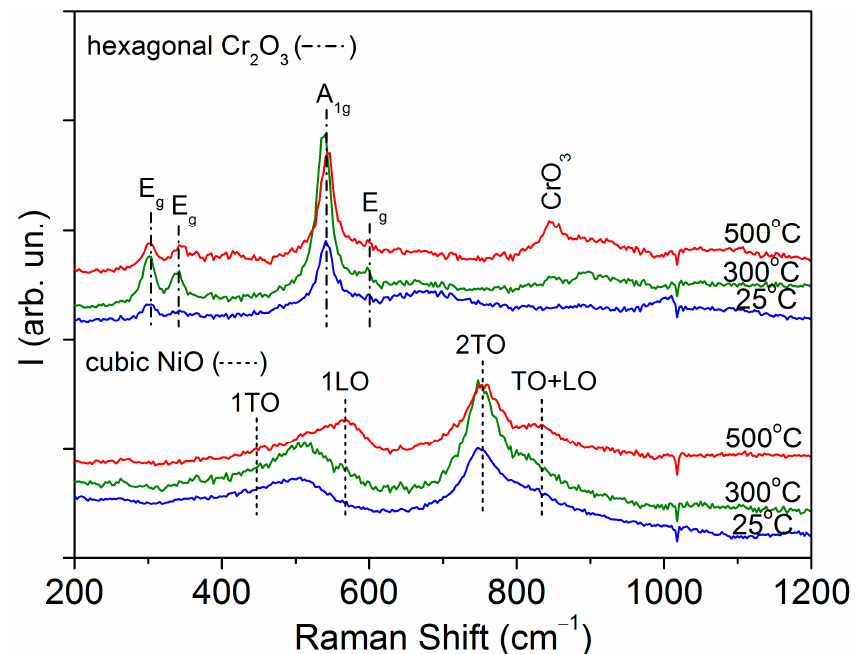
Figure 2. Raman spectra corresponding with the nickel oxide and chromium oxide samples as grown at room temperature and after heating in air at 300 ◦ C or 500 ◦ C. The optical transmission spectra of the various samples are given in Figure 4. This included the standard photopic vision V( λ ), which described the spectral sensitivity of the human eye centered at λ V = 0.55 µ m to better asses the transparency of the films. The visible transmittance (that is, the value T V taken at λ V ) showed the same evolution for the NiO and Cr 2 O 3 layers, increasing from T V = 36 ± 2% for the as-grown films to 54% after heating at 300 ◦ C and higher, to 72%, when the temperature increased to 500 ◦ C. An increment in the visible transmittance with an increasing annealing temperature has been reported for analogous coatings [45–47] with a maximum value around 70% at a 0.55 µ m wavelength [46,47]. In general, the optical transmission is expected to depend on various film properties such as impurity centers, surface roughness and level of crystallinity. For these smooth layers, structural defects and interstitial O atoms existing in the as-deposited samples acted as impurities and led to scattering and/or the absorption of incident light. As a result of annealing, the mean crystallite size increased and the interstitial O atoms could diffuse out [45] leading to a decrease in the impurity level and the subsequent increment of the film transmittance with the heating temperature. Furthermore, the coexistence of metal ions in different valence states (Ni 2+ /Ni 3+ or Cr 3+ /Cr 6+ ), which share oxygen anion ligands, allows facile charge transfer processes involving optical absorption in the visible range [23]. The structural data indicated that such coexistence was favored in the as-grown samples but subsequent heating produced an evolution to the most stable valence